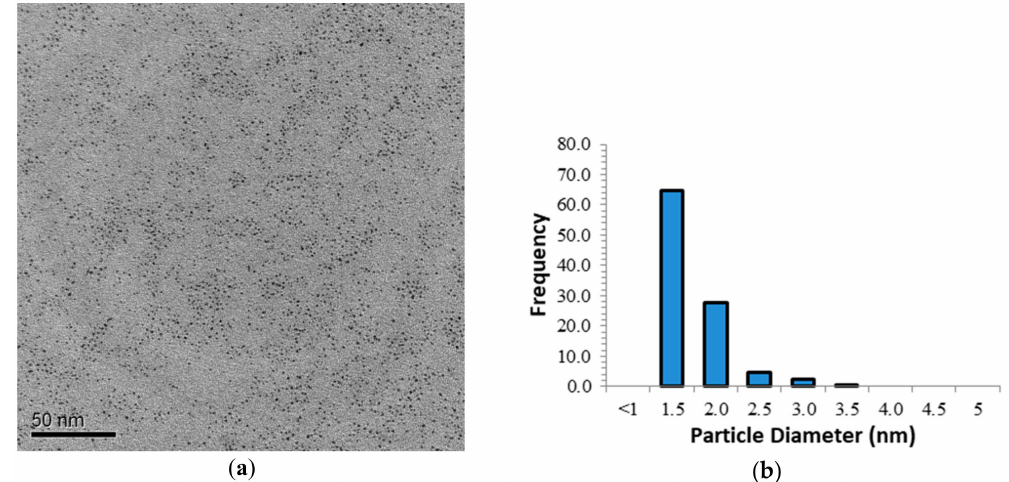
Figure 1. ( a ) TEM image and ( b ) size distribution histogram of PtNP generated from sodium S- octylthiosulfate. Reproduced from Ref. [64] with permission from the American Chemical Society,